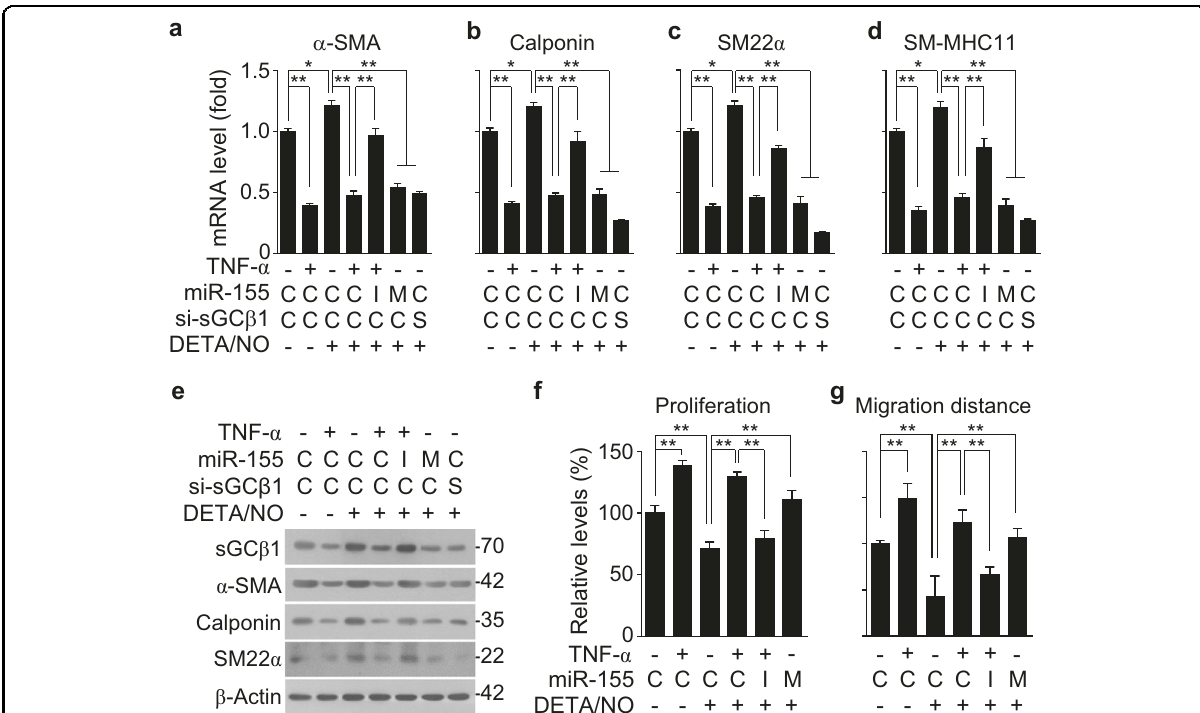
Fig. 5 TNF- α -induced miR-155 exerts VSMC phenotypic switching. HASMCs were transfected with 80 nM of control miRNA and siRNA (C), miR- 155 mimic (M), miR-155 inhibitor (I), or sGC β 1 siRNA (S) and stimulated with or without TNF- α (10 ng/mL) for 24 h, followed by treatment with DETA/ NO (100 μ M) for another 24 h. a – e The mRNA and protein levels of VSMC-speci fi c marker genes were determined by qRT-PCR ( n = 6) and Western blotting. f Cell proliferation was determined by a [ 3 H]-thymidine incorporation assay ( n = 3). g The migration distance was calculated as the average distance between the edges of the scratch fi eld ( n = 5). * P < 0.05, and ** P <